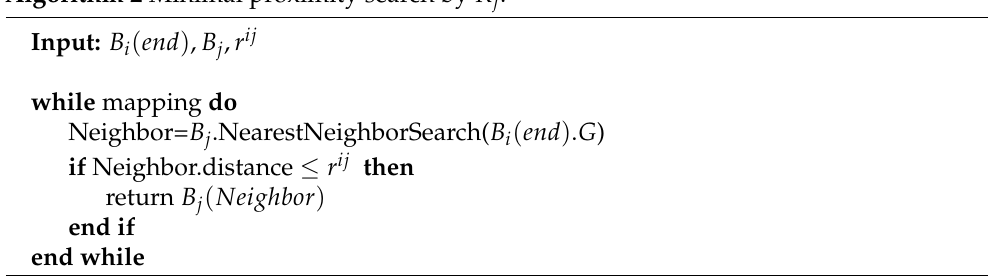
Algorithm 2 Minimal proximity search by R j